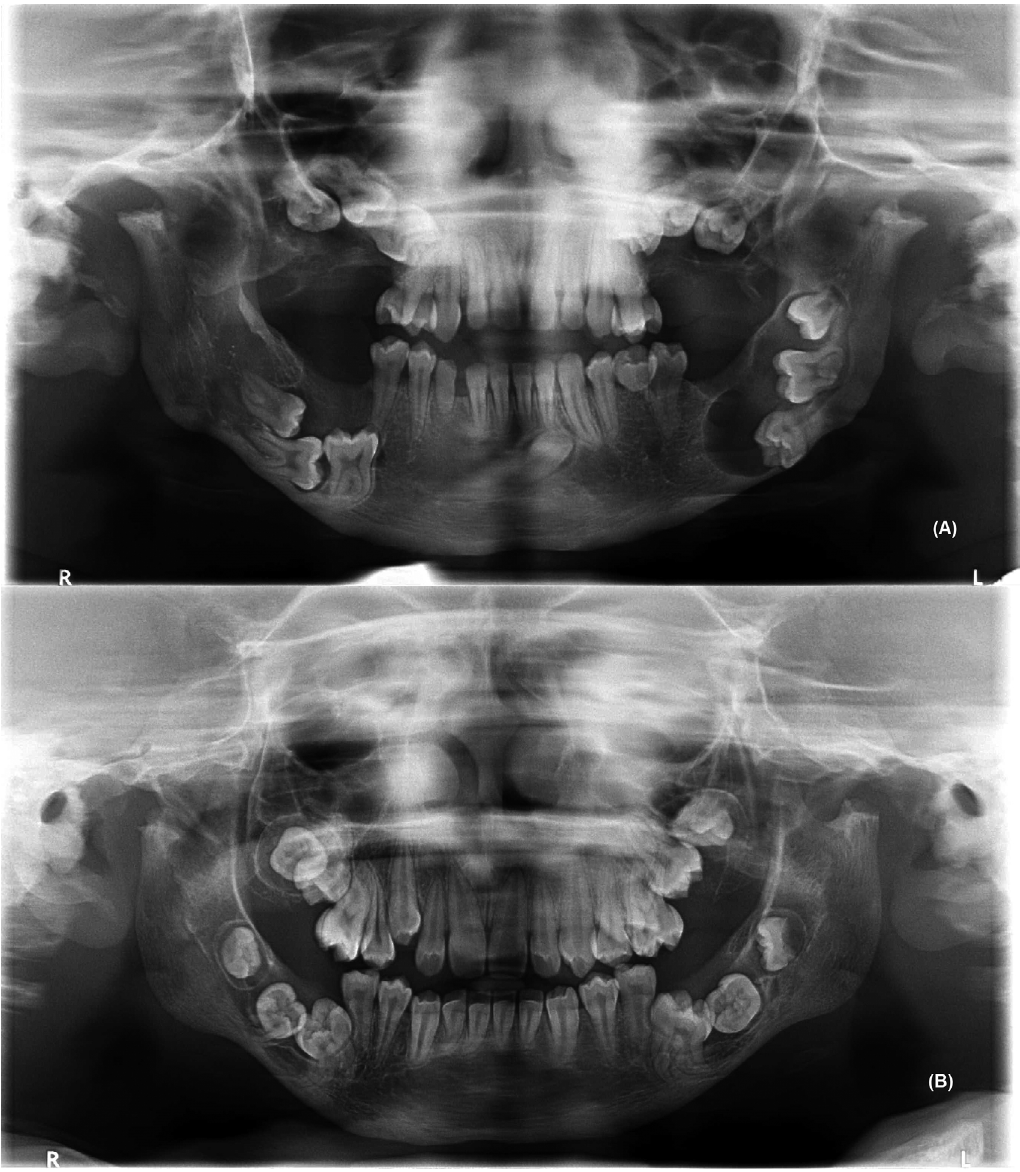
Figure 1- Panoramic radiographs of patients with MPS type VI, aged 19 (A) and 18 (B) years old, showing the presence of extensive maxillomandibular